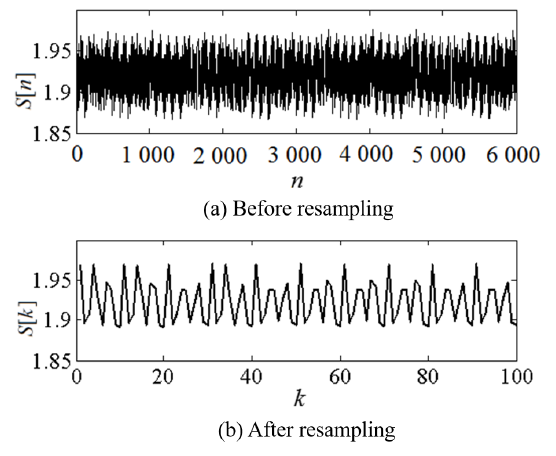
Figure 7. Instantaneous flicker sensation level. Table 2. Comparison of data volume, storage space, and execution efficiency before and after method